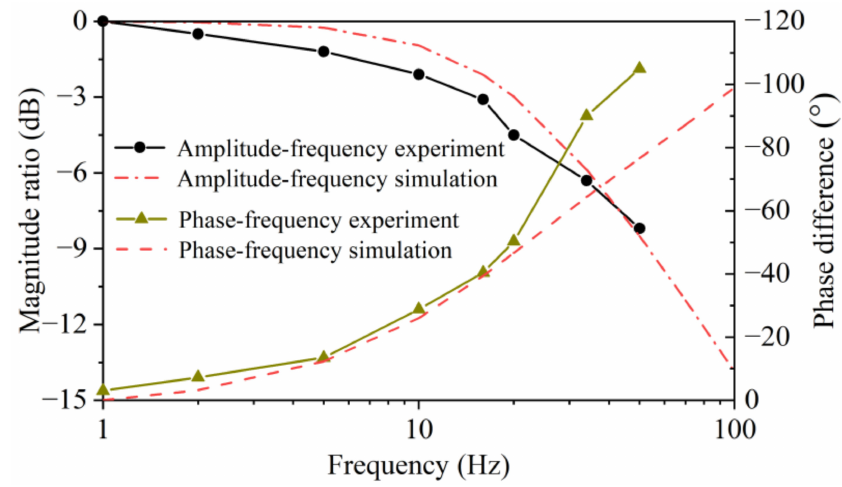
Figure 21. Frequency response curve.